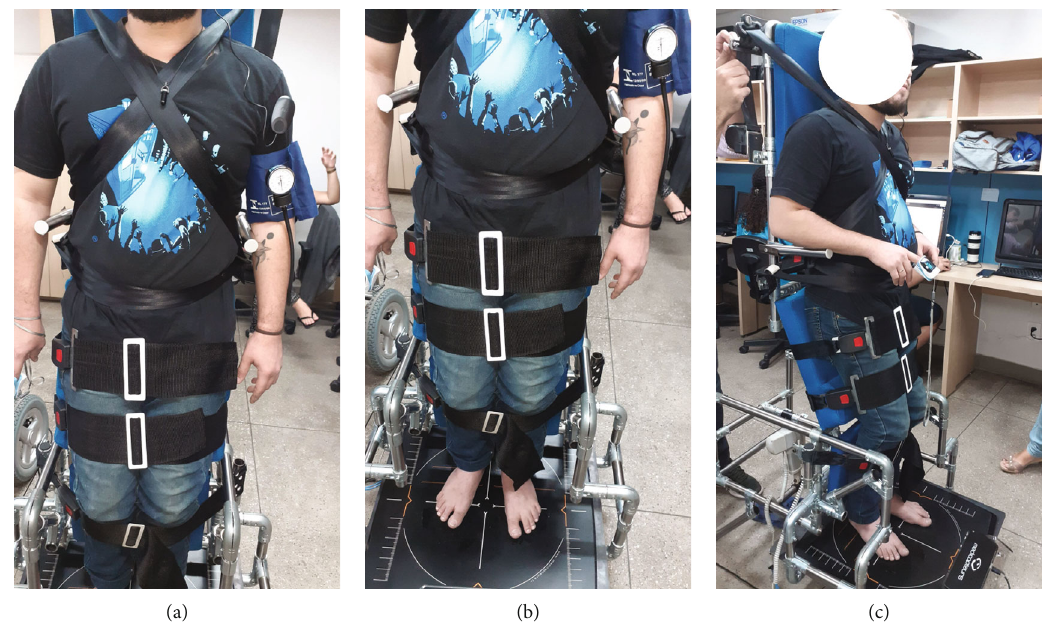
Figure 1: (a) Trunk bands; (b) leg bands; (c): side view — stand